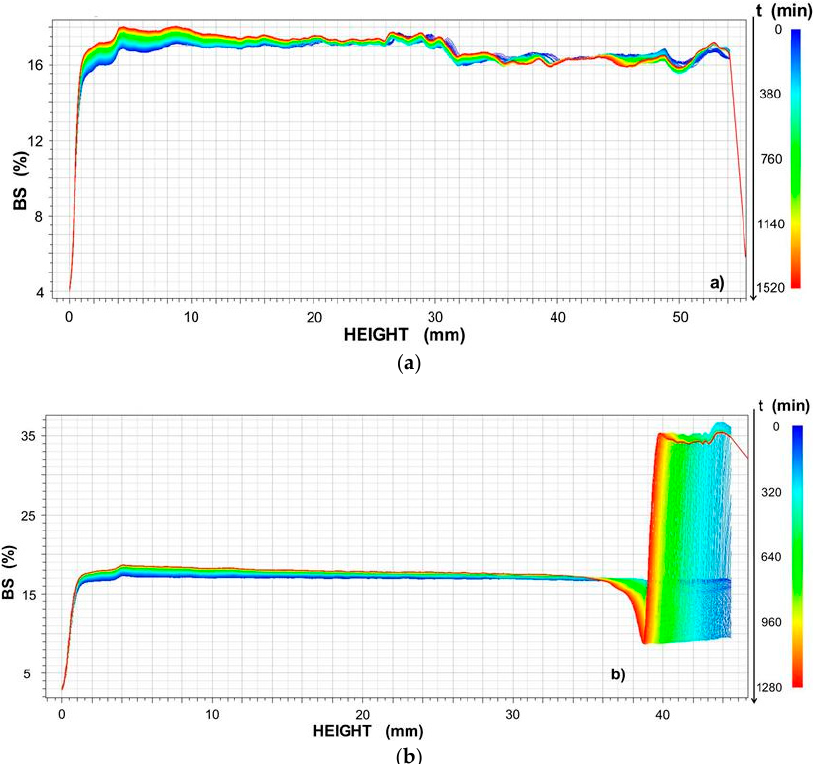
Energies 2017 , 10 , 354 10 of 14